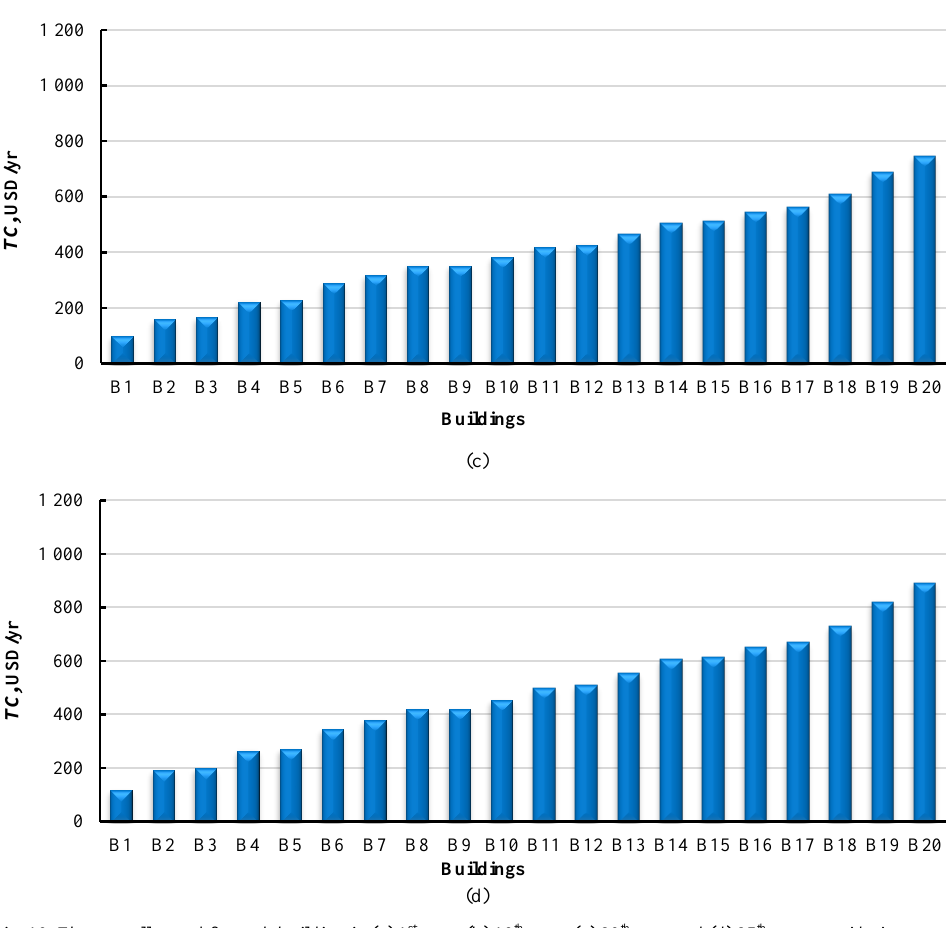
Fig. 10. The cost allocated for each building in (a) 1 st year, (b) 10 th year, (c) 20 th year and (d) 25 th year considering PV